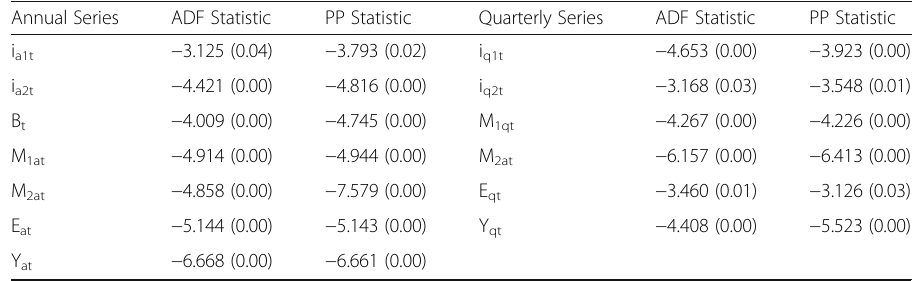
Table 2 Results of unit-root